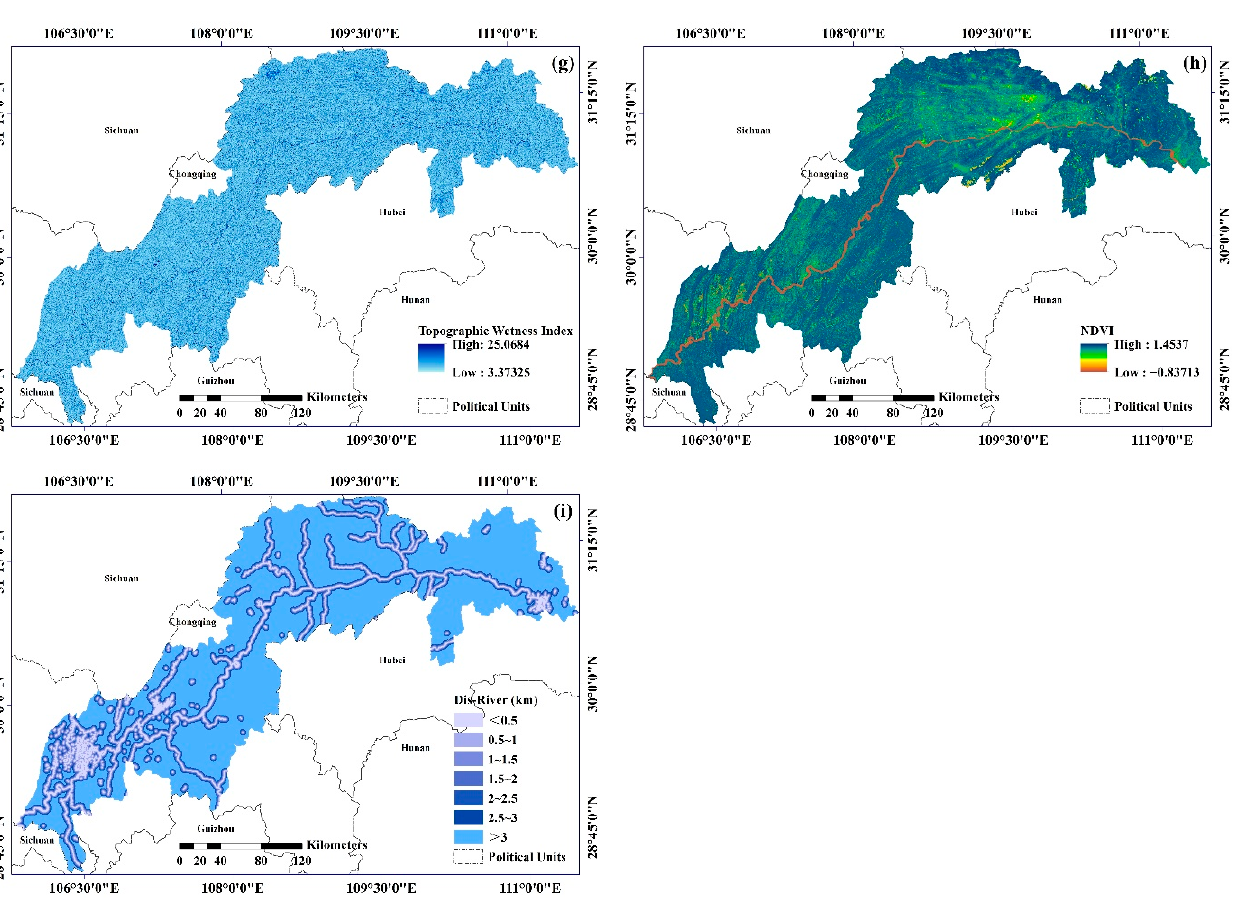
Figure 5. Indicator factor maps used for landslide susceptibility modeling. ( a ) Elevation, ( b ) slope, ( c ) plan curvature, ( d ) profile curvature, ( e ) distance to fault, ( f ) lithology, ( g ) TWI, ( h ) NDVI, ( i ) and distance to rivers.